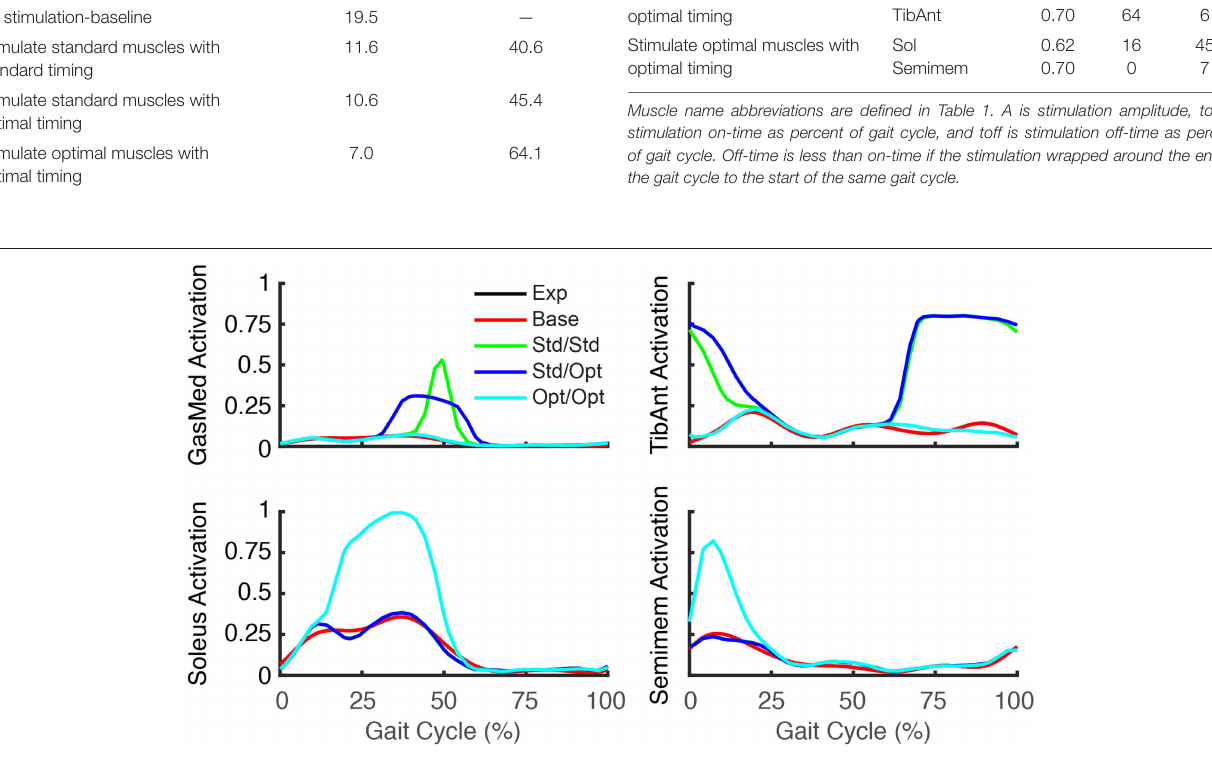
FIGURE 3 | Experimental and predicted activation patterns for electrically stimulated muscles. Activation patterns for standard muscle selection involving stimulation of GasMed and TibAnt (top row) and optimal muscle selection involving stimulation of Sol and Semimem (bottom row) are presented for the paretic leg. Exp indicates experimental curves, Base indicates curves from the baseline treatment optimization with no muscle stimulation, Std/Std indicates curves from the FastFES treatment optimization using standard muscle selection with standard stimulation timing, Std/Opt indicates curves from the FastFES treatment optimization using standard muscle selection with optimized stimulation timing, and Opt/Opt indicates curves from the FastFES treatment optimization using optimized muscle selection with optimized stimulation timing.